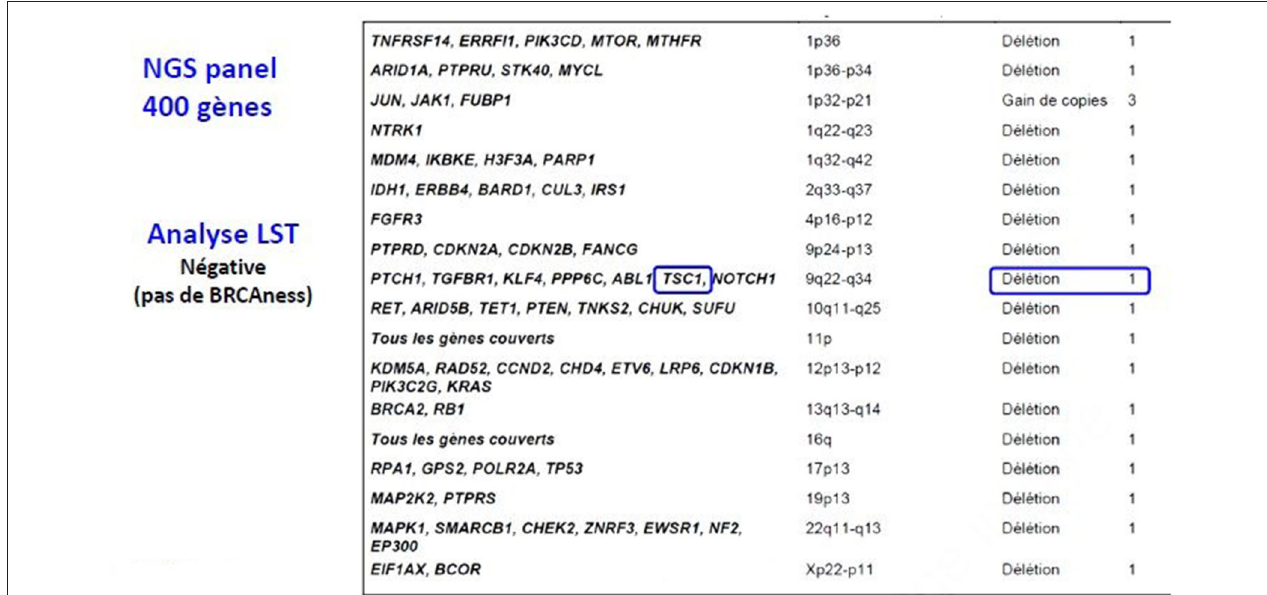
FIGURE 2 | NGS 400